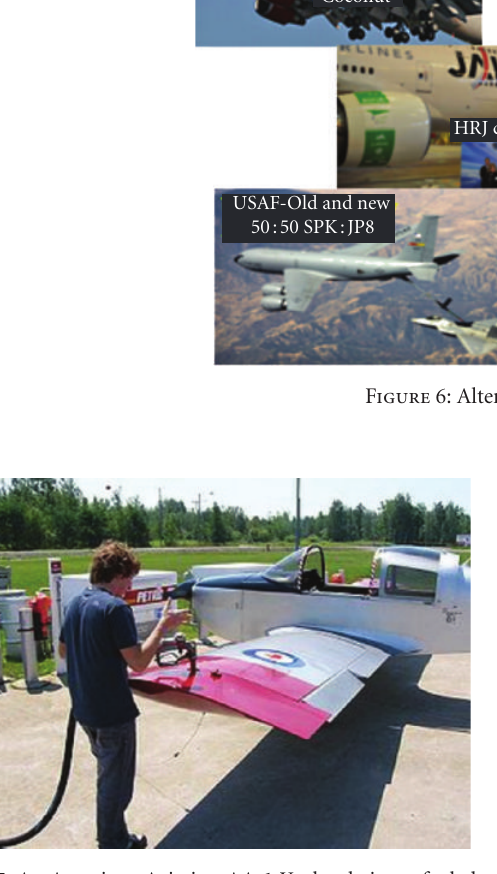
Figure 7: An American Aviation AA-1 Yankee being refueled with 100LL Av-gas [29].